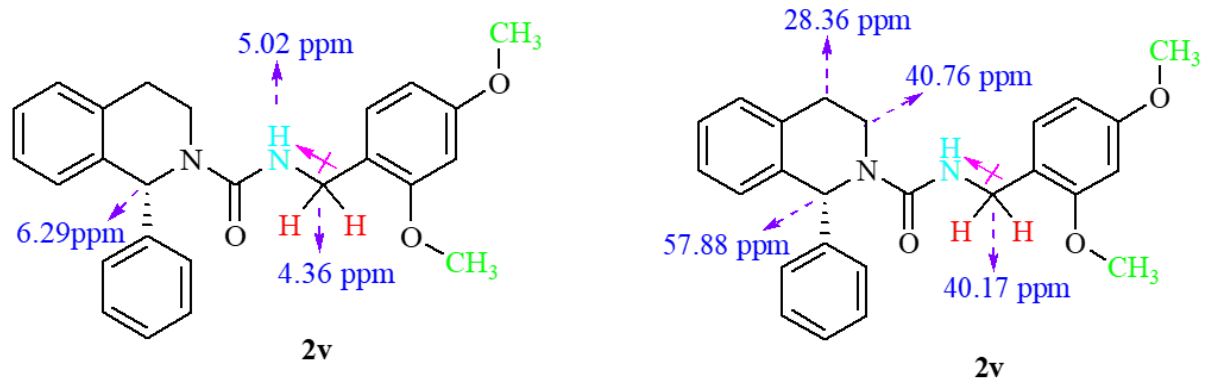
Figure 3. Upfield shifting and splitting of signal in compound 2v .